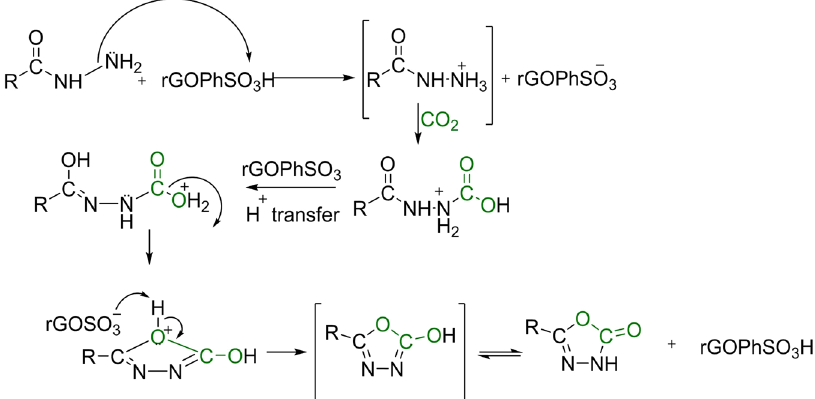
Figure 9. Postulated reaction mechanism of 5-substituted-3H-[1,3,4]-Oxadiazol-2-ones (SOxdOs) under